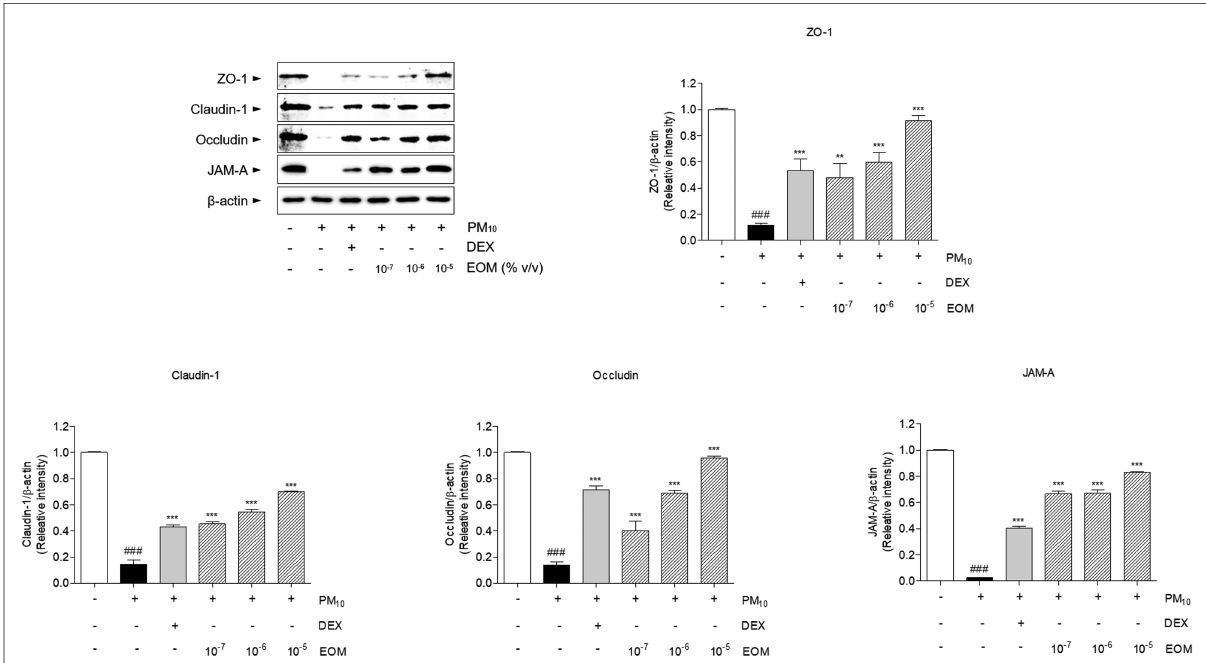
FIGURE 8 The expression of tight junction proteins in PM10-treated RPMI2650 cells. The levels of tight junction related protein were visualized by western blot analysis. Results are presented as mean±standard error of the mean. ### p <0.001 vs. CTR group * p <0.05, ** p <0.01 and *** p <0.001 vs. PM10- treated